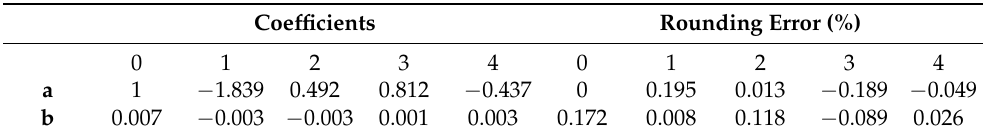
Figure 7. The impulse response of hamming filter with window of length 17 ( red ) and the 4th equivalent IIR ( blue ) filter. It is worth noticing that the impulse response of the equivalent filter presents a small stopband ripple (around 20th sample) which can be considered negligible. Table 2. Equivalent 4th IIR coefficients scaled by 2 8 and the percentage error introduced by integer